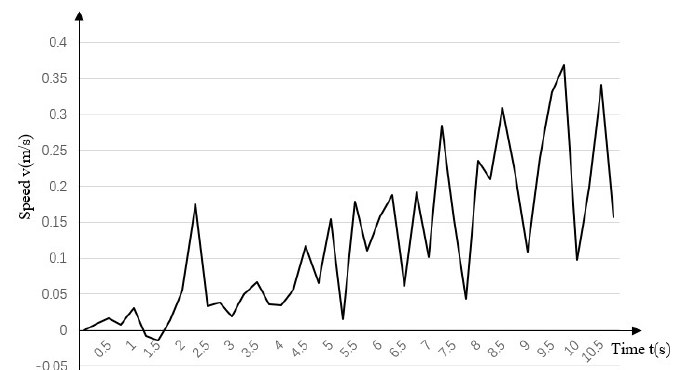
Figure 10. Yaw speed curve during turning gait.